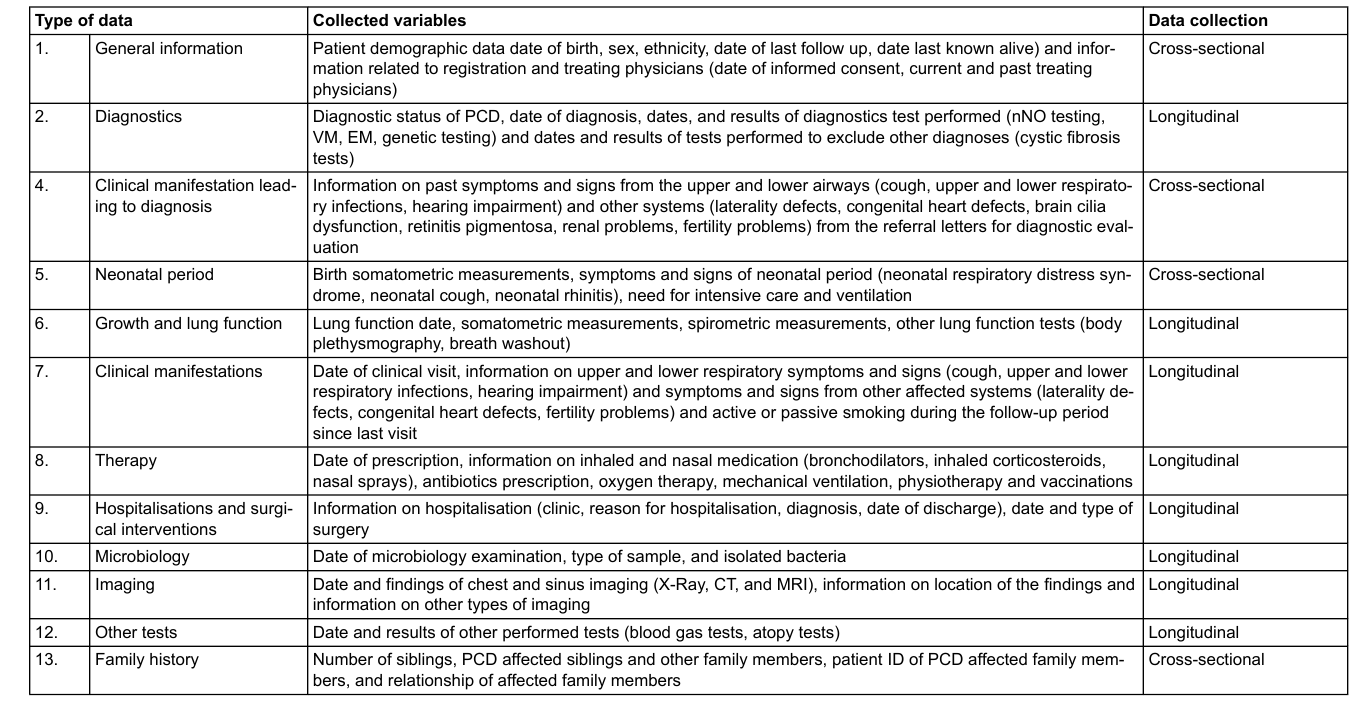
Table 1: Description of data collected in the Swiss PCD